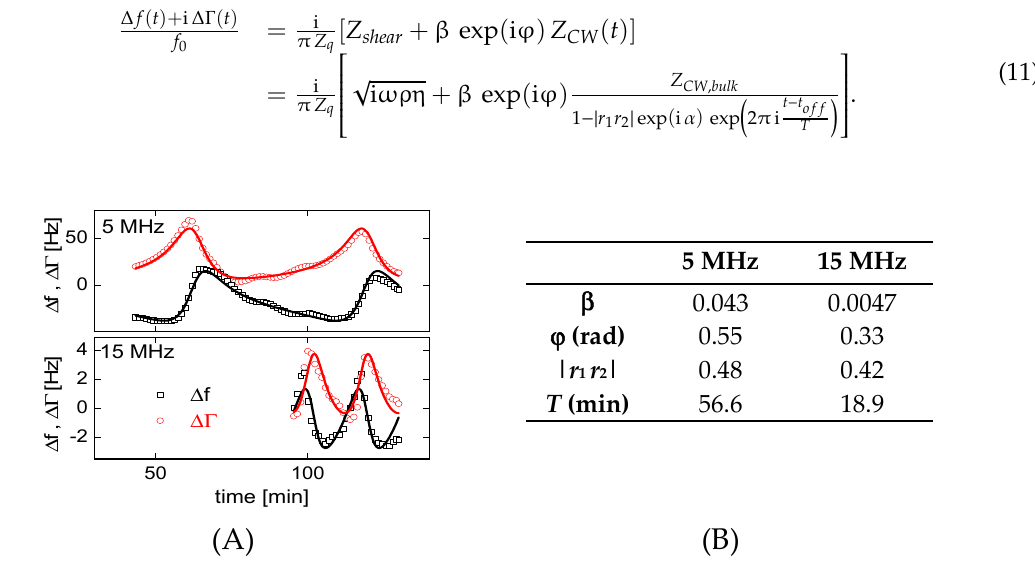
Figure 9. ( A ): Fits of Equation (11) to a subset of the data from Figure 7 (5 MHz and 15 MHz). The cuvette resonances are reproduced. ( B ) Corresponding fit parameters.